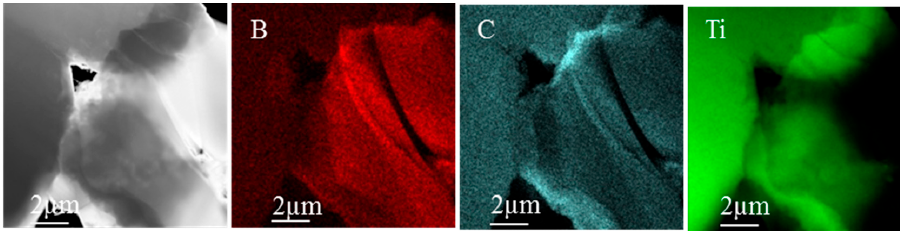
Figure 5. TEM image and compositional mapping of TiC formation in TMCs produced at 1000 °C for 15 min.